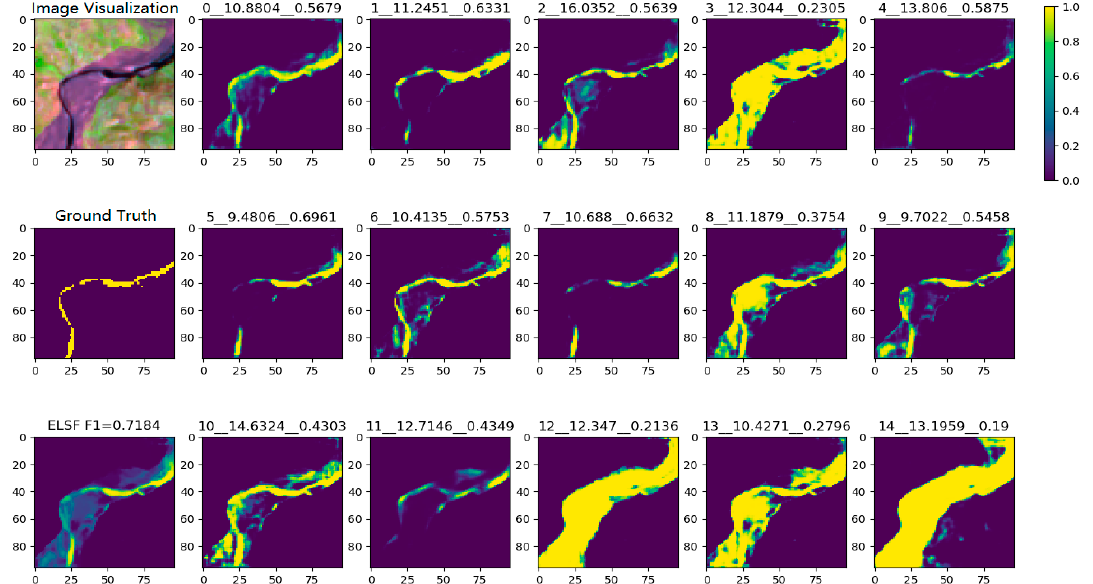
Figure 13. Figures of the tested RSIR sample visualization, ground truth, ELSF method (column 1). Segmentation results from each individual group training CNN model. The sub-titles represent Group-ID__TestSample-to-Center-Distance__F1-Score (column 2 to column